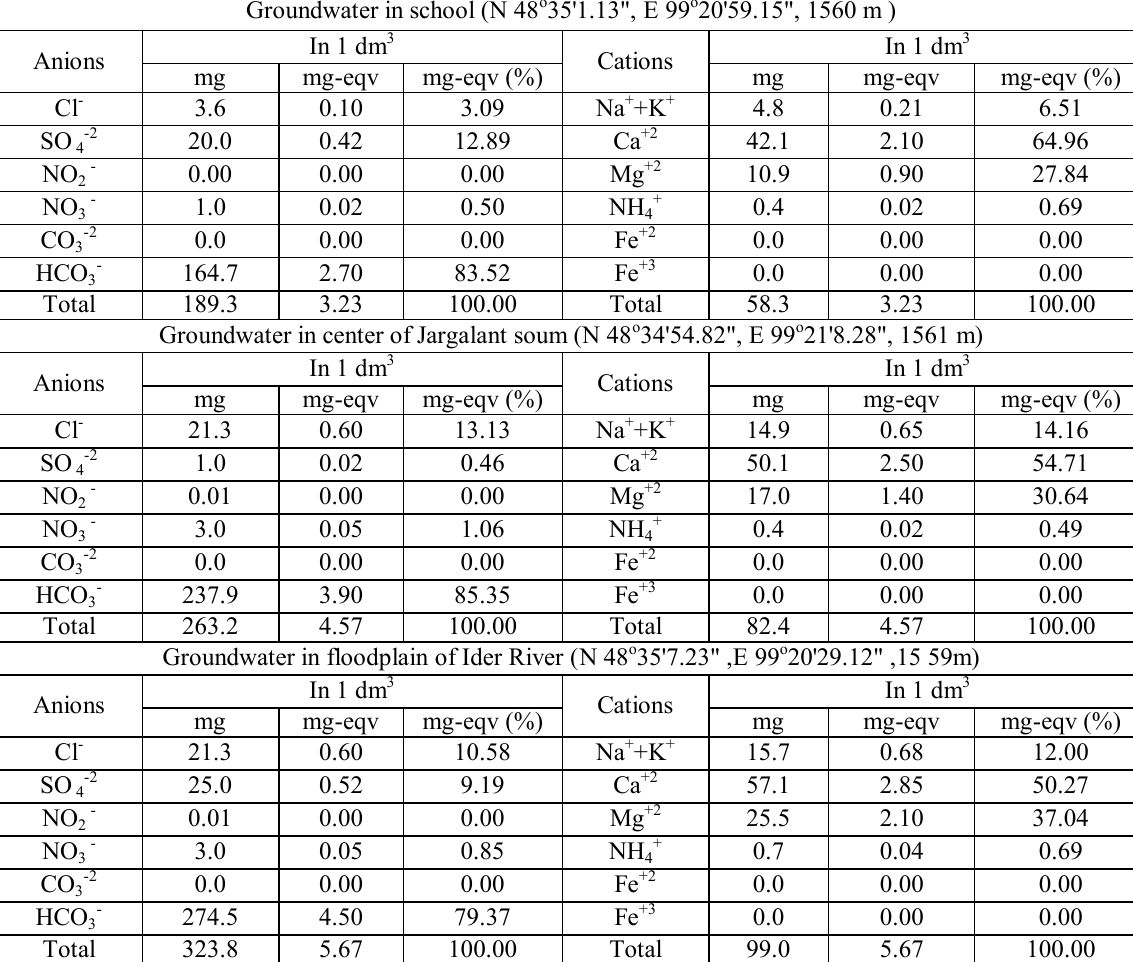
Table 3 . Ions in groundwaters in valley of the